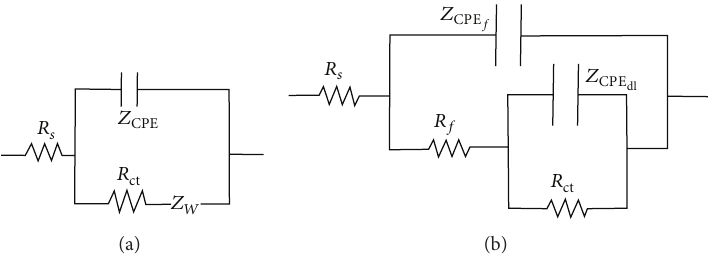
Figure 10: Equivalent circuits; (a) metal electrodes corroded without inhibitor; (b) metal electrodes corroded in presence of inhibitor.